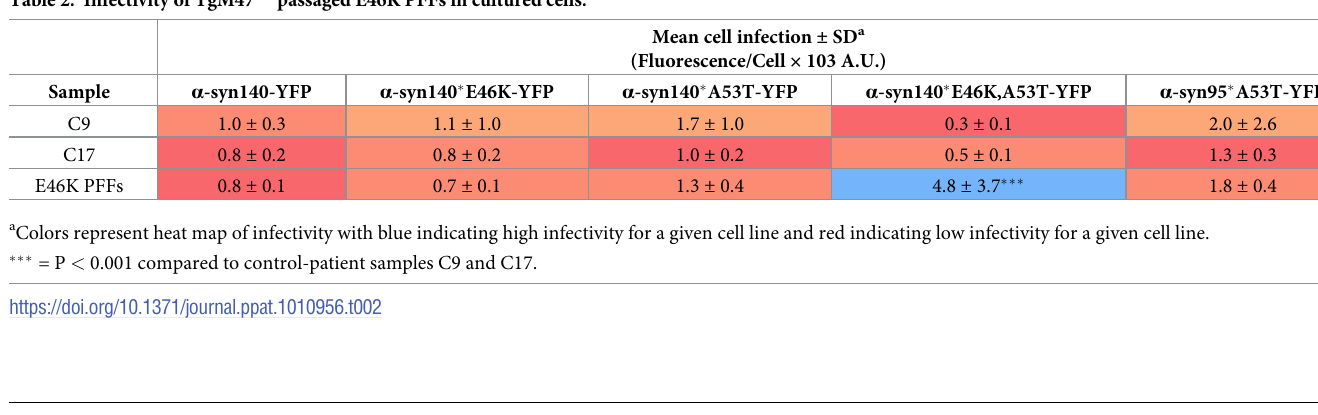
Table 2. Infectivity of TgM47 +/- passaged E46K PFFs in cultured cells.